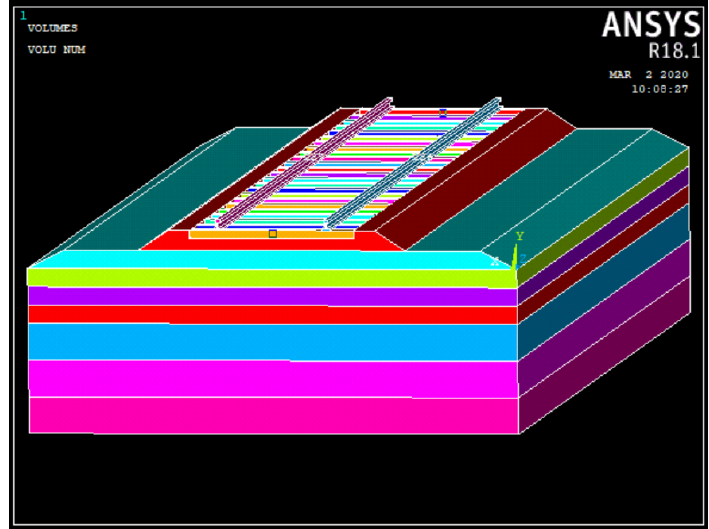
Fig. 5. Railway track model.